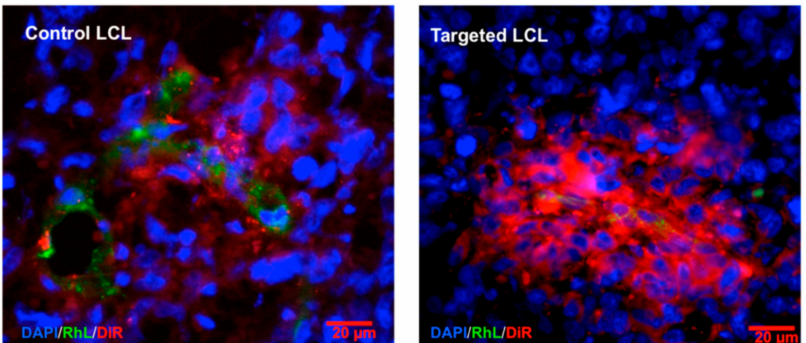
Figure 6. Fluorescence microscopy images of PC3 tumor cryosections (dissected from right hind limb) after 48 h post injection showing higher targeted LCL internalization than control. Liposomes are depicted in red, nuclei in blue, and endothelial cells in green. Adapted with permission from